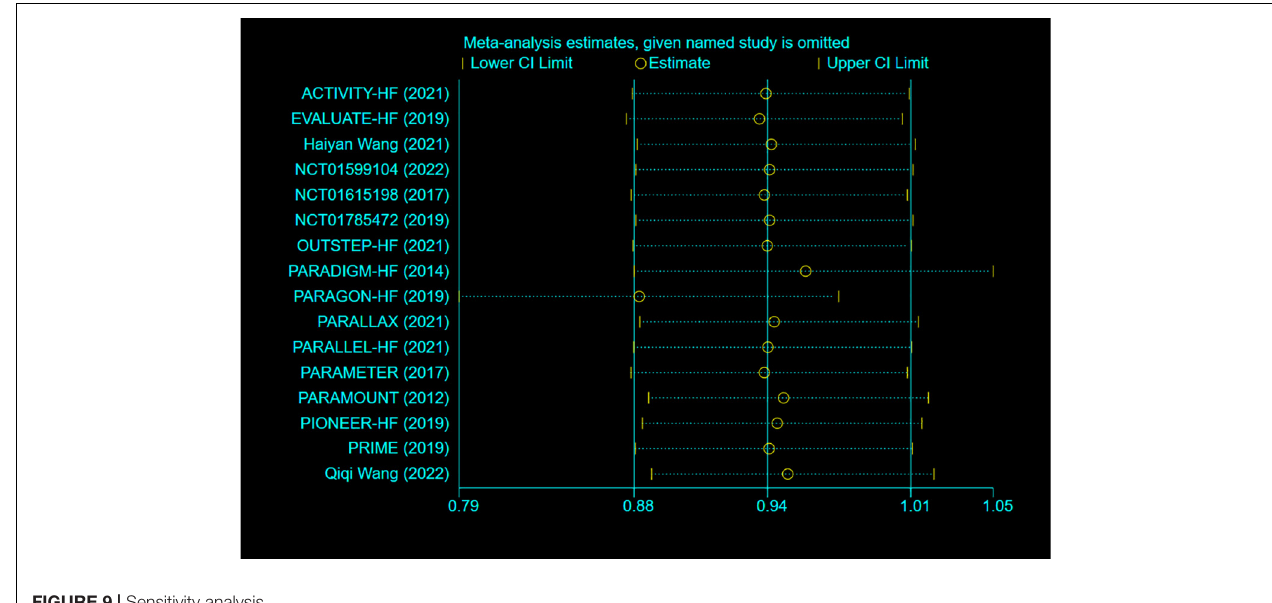
FIGURE 9 | Sensitivity analysis.